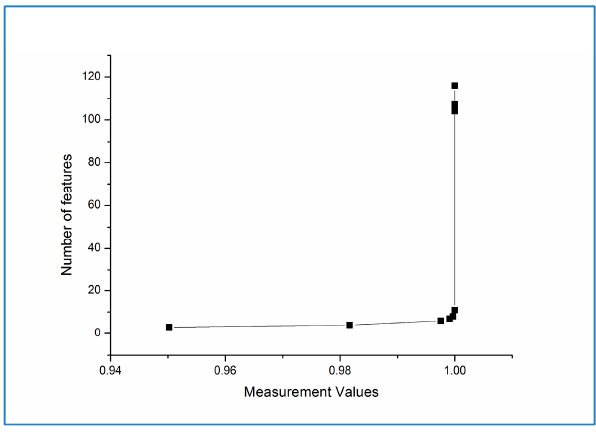
Figure 8. ( a ) Test set measurement results; ( b ) Weak equivalence app measurement results.